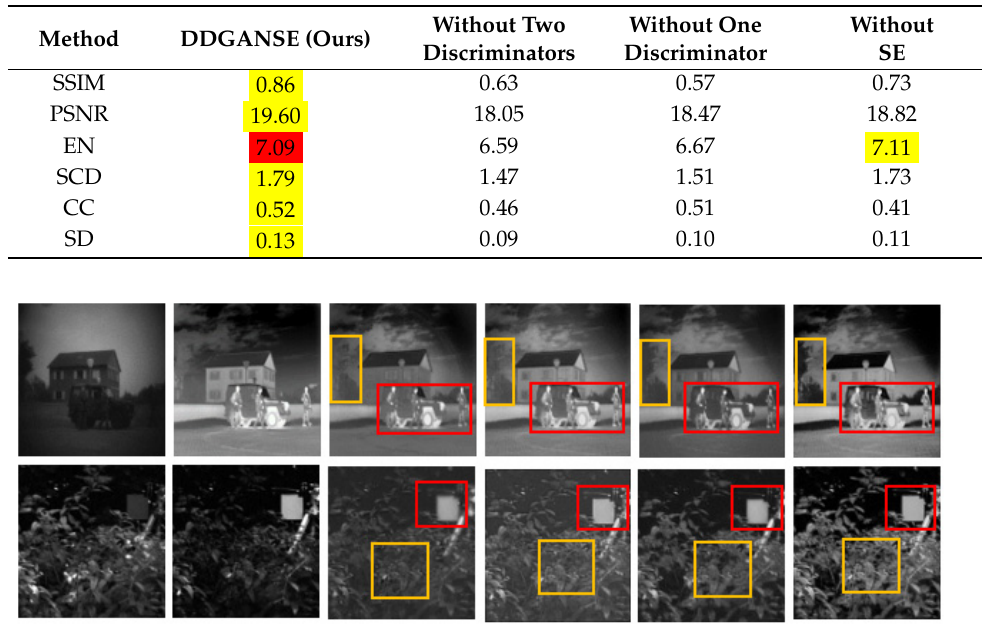
Table 3. Quantification results is for our proposed method with different innovative components. (The best value is marked in yellow, and the second-best value is marked in red).